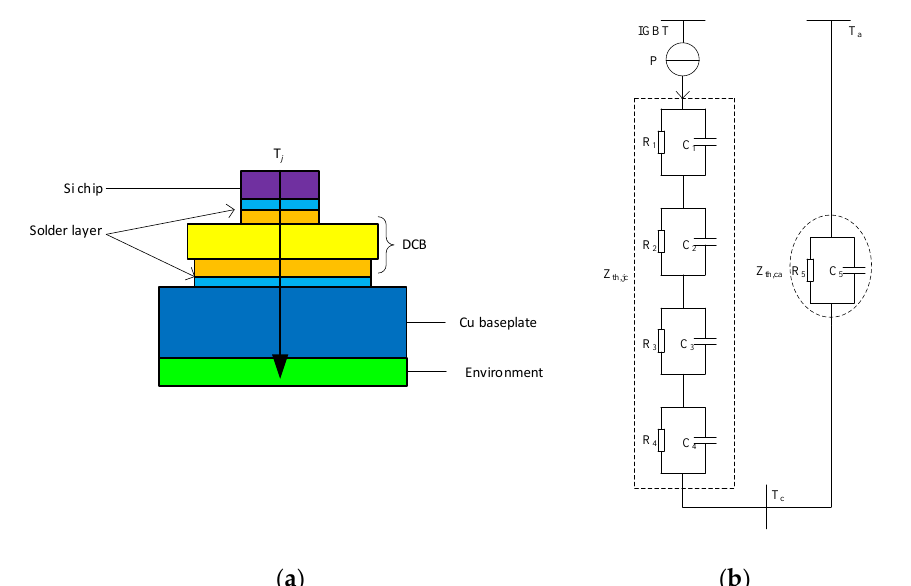
Figure 3. IGBT power module packaging structure diagram and its fourth-order Foster thermal network model. ( a ) The packaging structure diagram of IGBT; ( b ) The fourth-order Foster thermal network model of IGBT.